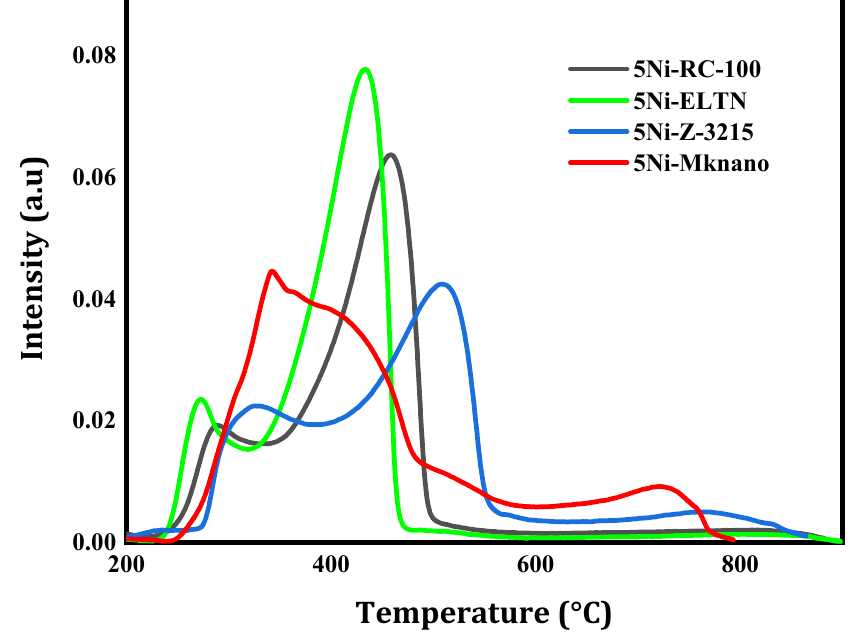
Figure 2. TPR-H 2 profiles of nickel catalysts supported on different zirconia sources.